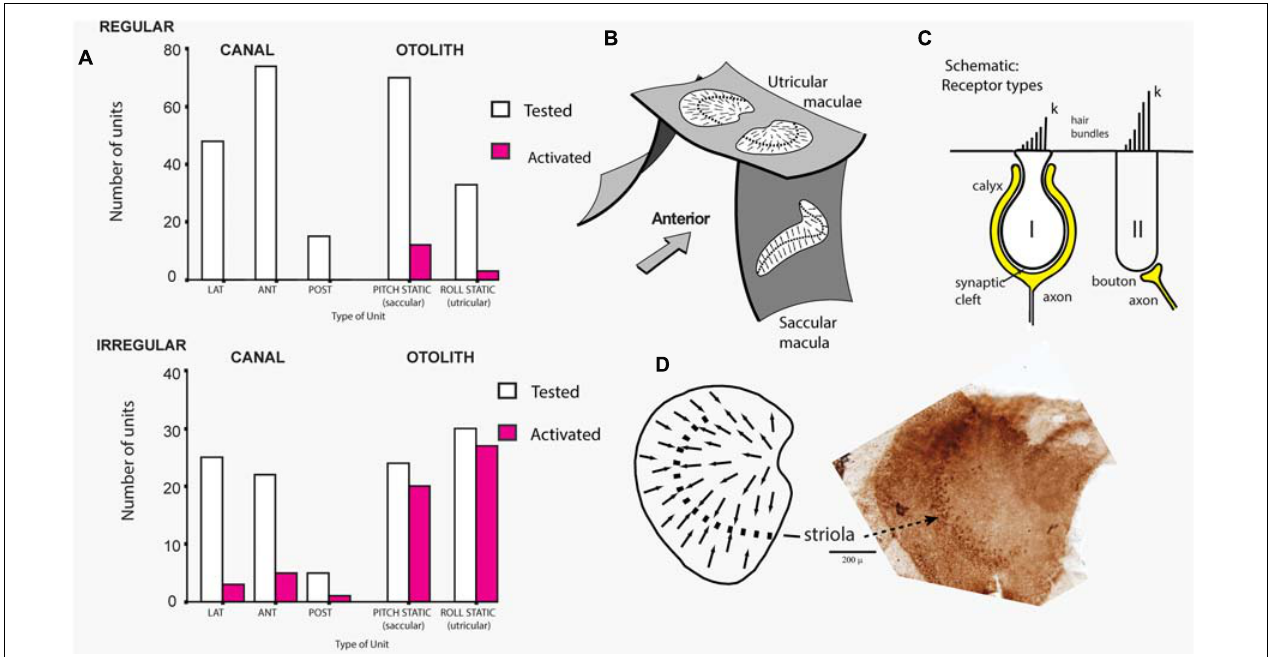
FIGURE 3 | (A) Proportions of primary vestibular afferent neurons tested (open bars) and activated (filled bars) by bone-conducted vibration (BCV) stimuli from each vestibular sensory region. Top chart - Regular neurons, bottom chart irregular neurons. Lat, horizontal canal; Ant, anterior canal; Post, posterior canal. The otolith neurons are divided into Pitch static and Roll static. The results show that only a very small proportion of semicircular canal neurons, or regular otolithic neurons, were activated. However, a large proportion of otolithic irregular neurons were activated. Reproduced, from Curthoys et al. (2006) with permission of Springer. (B) Schematic representation of the plates of otolithic receptors (the utricular and saccular maculae) of the inner ear. The arrows show the preferred polarizations of hair cell receptors across the maculae. The dashed lines are lines of polarity reversal, where the preferred polarizations of receptors reverse. The striola refers to a thin band of receptors on either side of the line of polarity reversal. (C) Schematic representation of type I and type II receptor hair cells and their calyx and bouton afferent terminals. The longest cilium, the kinocilium (k), defines the preferred direction of cell polarization (shown by small arrows in B and D ). The type I receptor is enveloped by the calyx afferent ending. (D) Schematic representation of a dorsal view of the whole guinea pig utricular macula. Adjacent to this schematic is a dorsal view of a guinea pig utricular macula treated by calretinin—the band of cells comprising the striola is clearly visible. Reproduced from Curthoys et al. (2012), with permission from